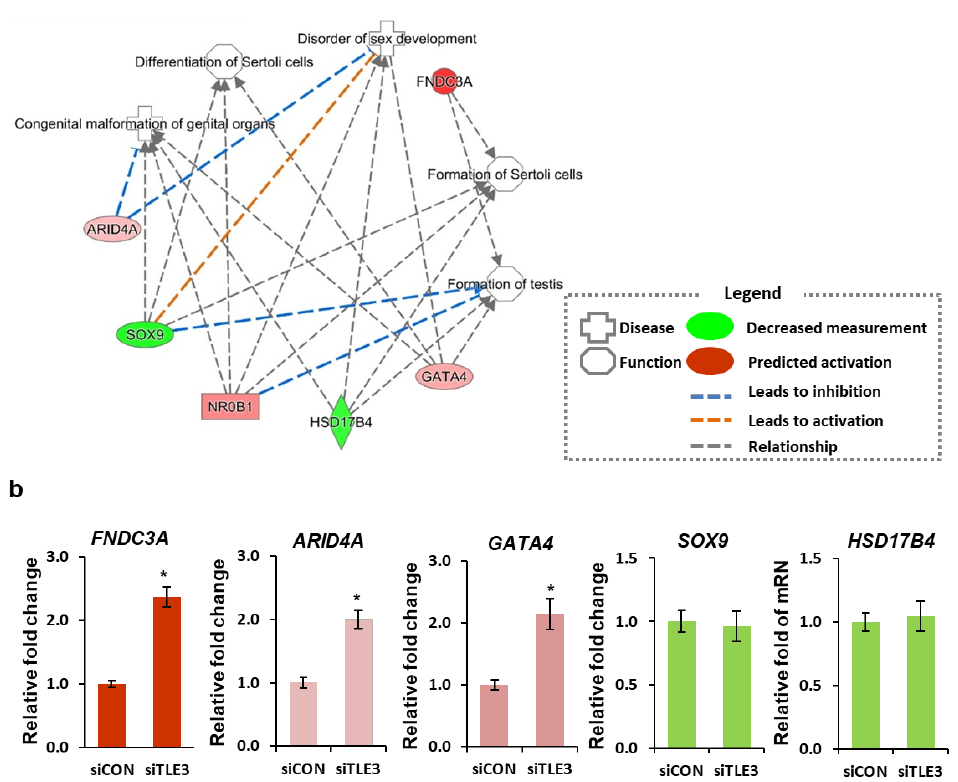
Figure 5. Differential expression of Sertoli cell-associated genes in TLE3-knockdown TM4 cells. ( a ) The gene interaction network for Sertoli cell metabolism generated by Ingenuity Pathway Analysis (IPA). The up-regulated genes are labeled in different shades of red, and down-regulated genes are labeled in green upon TLE3 knockdown. The color intensity represents fold change in gene expression. ( b ) qRT-PCR analysis of candidate genes in TLE3 knockdown TM4 cells. Expression level of different genes was normalized with Gapdh mRNA. Data are represented as mean ± SEM. The Student t-test was applied to calculate p -value. *p < 0.05.